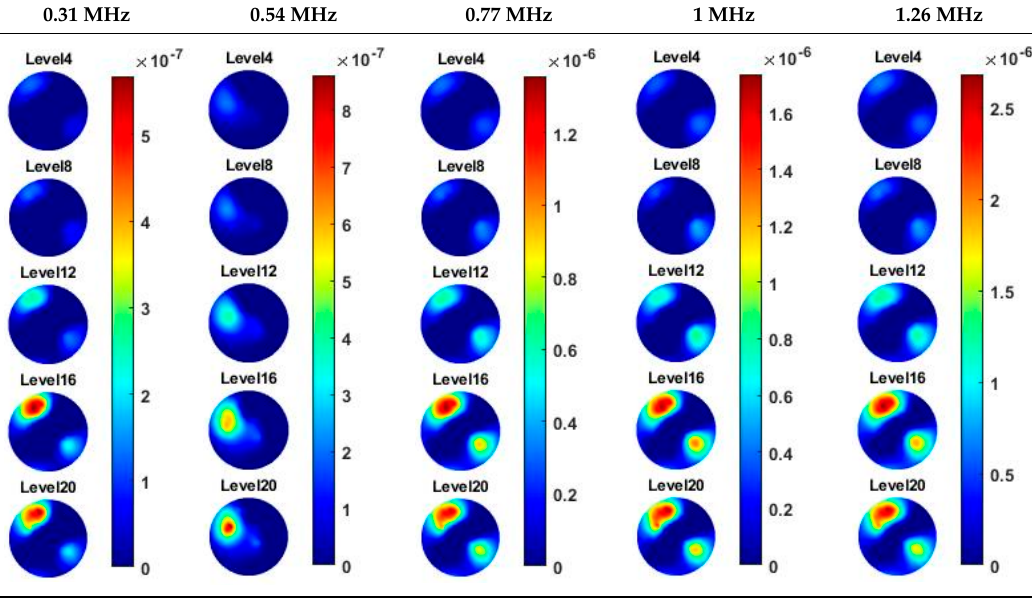
Table 4. Sliced image of horizontal layer for double corn kernels with multi-frequency.